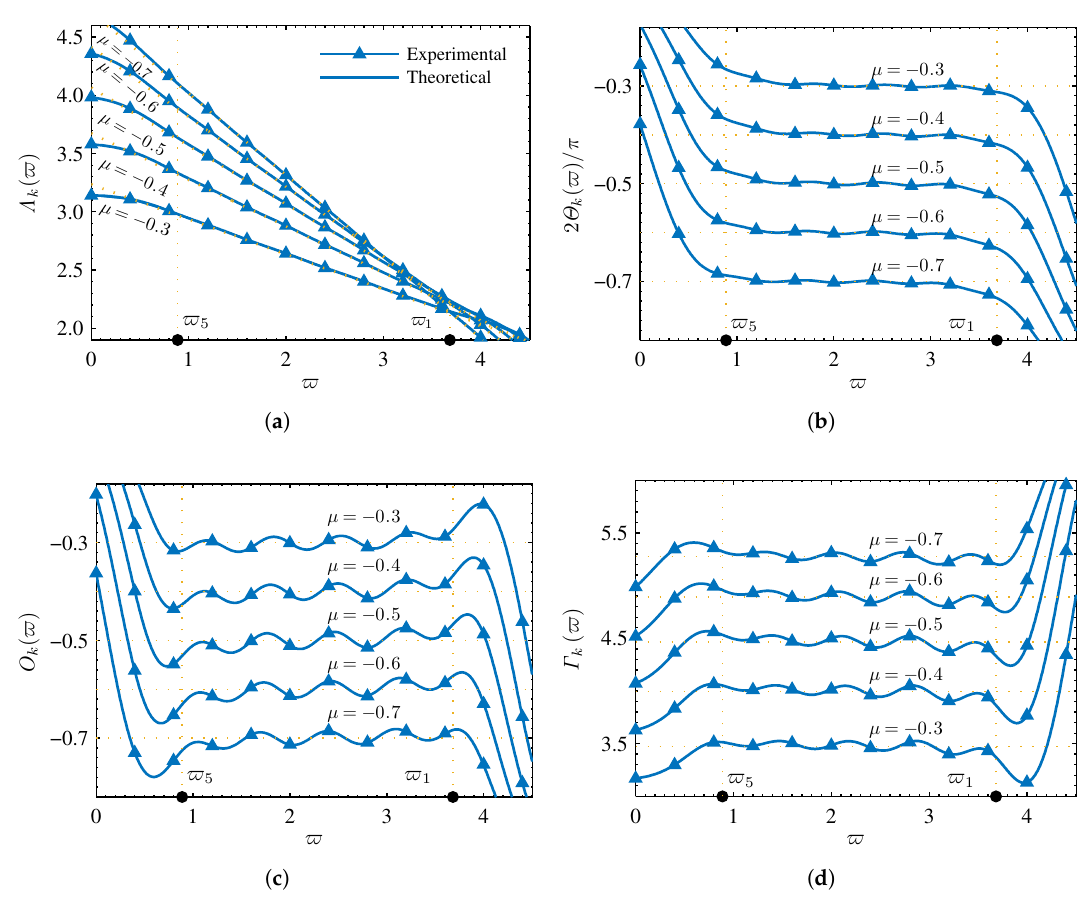
Figure 4. Frequency characteristic curves of VSFF: k = 5, σ = 5, R =330 Ω , and C = 0.1 µ F: ( a ) amplitude-frequency characteristic; ( b ) phase-frequency characteristic; ( c ) order-frequency charac- teristic; ( d ) F-frequency